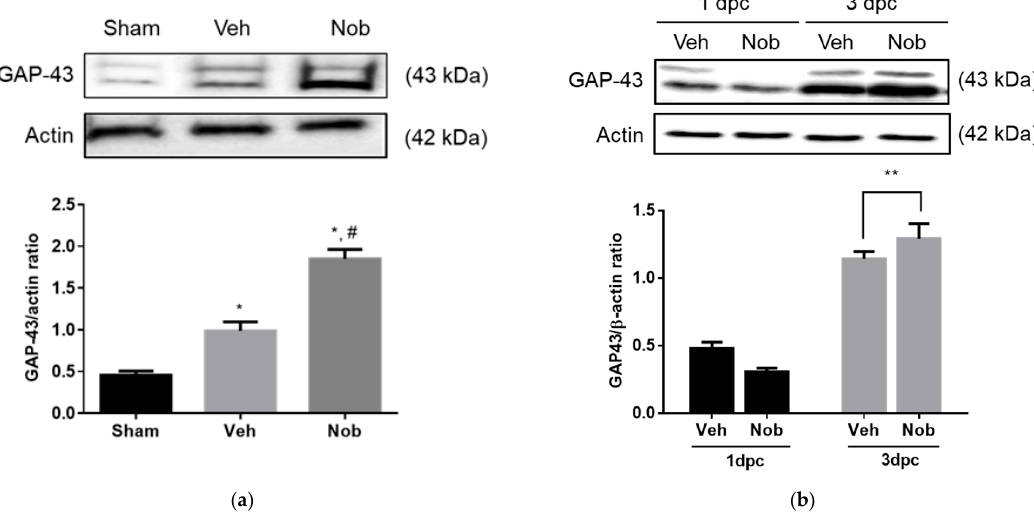
Figure 3. Nobiletin upregulated GAP-43 levels both in primary cultured Schwann cells and in the injured sciatic nerve. ( a ) Schwann cells were cultured at 3 dpc, and 12 h later, nobiletin was added to each well at a concentration of 50 μ M. Schwann cells were incubated for 72 h and then harvested for Western blot analysis. Nobiletin upregulated expression levels of GAP-43 in injury-preconditioned Schwann cells compared to the vehicle group ( n = 18, this culture repeated 3 times with 2 rats each). * p < 0.05 compared to shame group; # p < 0.05 compared to vehicle treated group. ( b ) Nobiletin at a concentration of 50 µ M was locally injected into a segment 10 mm distal to the injury site, and 1 and 3 days later all sciatic nerves were dissected. The quantitative graph represented that GAP-43 showed a significant increase in the nobiletin treated group at only 3 dpc compared to subjects in the vehicle treated group ( n = 16). ** p < 0.01 compared to vehicle treated group; Veh, vehicle group, Nob, nobiletin group; dpc, days post crush.